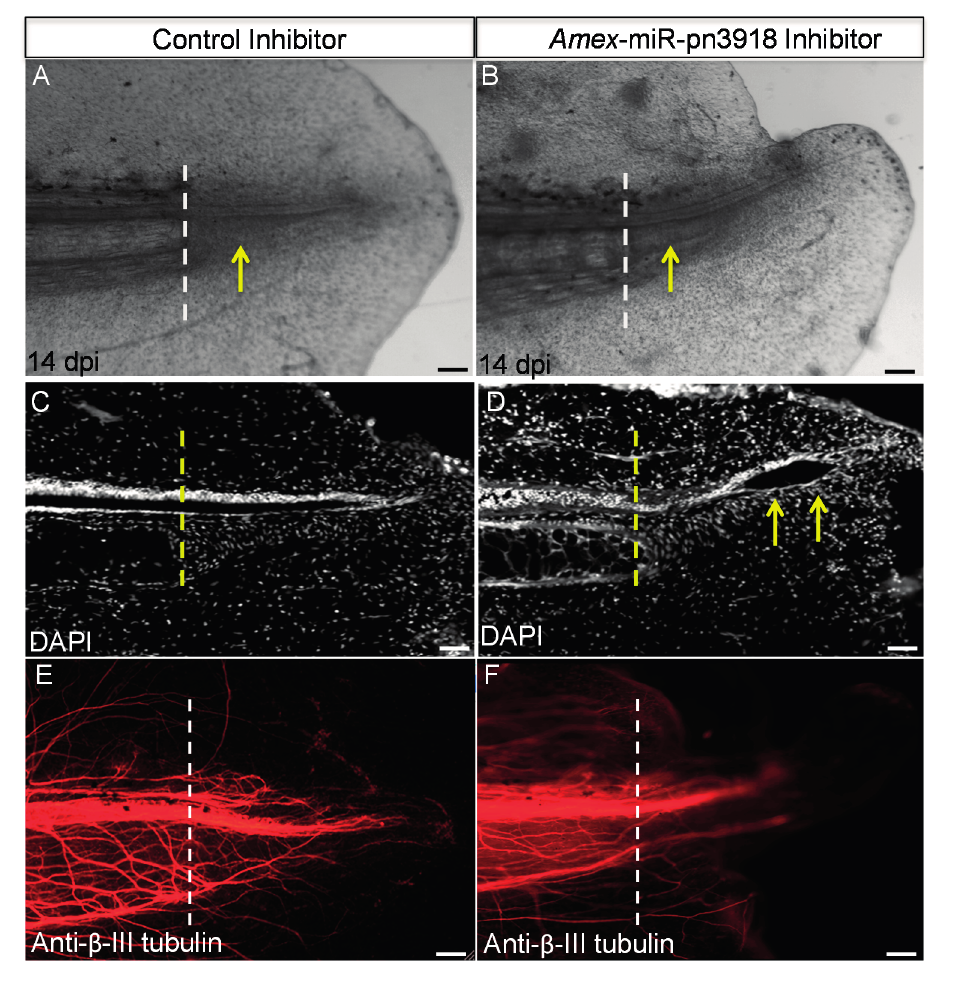
Figure 4. Inhibition of Amex -miR-pn3918 causes defects in tail regeneration injection of a control versus synthetic inhibitor of Amex -miR-pn3918 led to defects in skin regeneration ( A , B ). In addition defects in regeneration of the neural tube were visible, a terminal vesicle (yellow arrows) like structure was still present in the Amex -miR-pn3918 inhibitor animals 14 days post injury, but was no longer present in the controls ( C , D ). In addition, whole mount β -III tubulin staining revealed less axons to have regrown in the inhibitor treated animals ( E , F ). The dashed line in all panels indicates the original plane of amputation. Arrows in ( A , B ) indicate the regenerate, while in ( D ) arrows indicate the terminal vesicle structure still present. Control n = 10, Inhibitor n = 15. Scale bar = 100